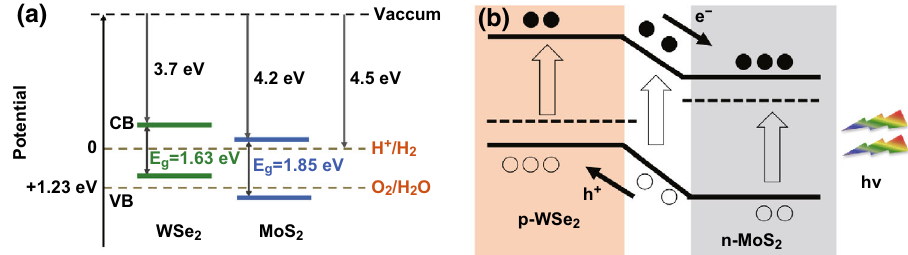
Fig. 5 a Energy band position of monolayer MoS 2 and WSe 2 compared with redox potentials for water splitting. b MoS 2 /WSe 2 heterojunction formed a type II band alignment. When illuminated, photo-generated electrons are transferred from valence band to conduction band and the built-in electric field helps to separate